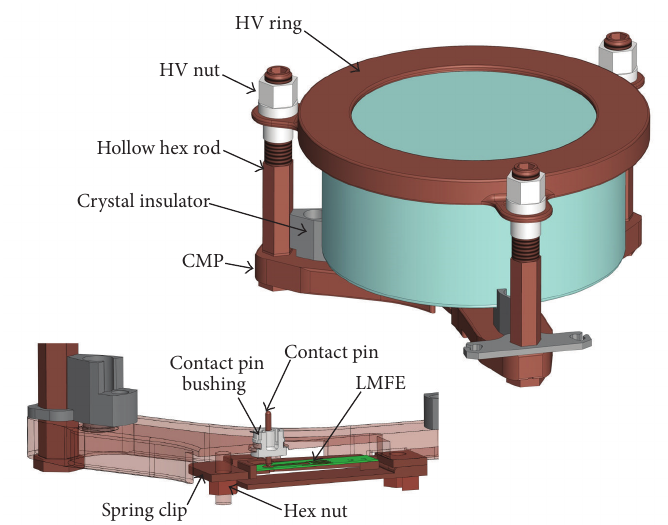
Figure 4: A rendering of the detector unit design (see text for details).